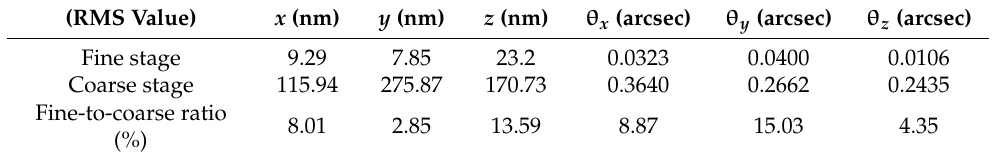
Figure 12. The evaluated minimum positioning resolution data of the dual servo stage: ( a ) x direc- tion, ( b ) y direction, ( c ) z direction, ( d ) θ x direction, ( e ) θ y direction, ( f ) θ z direction.